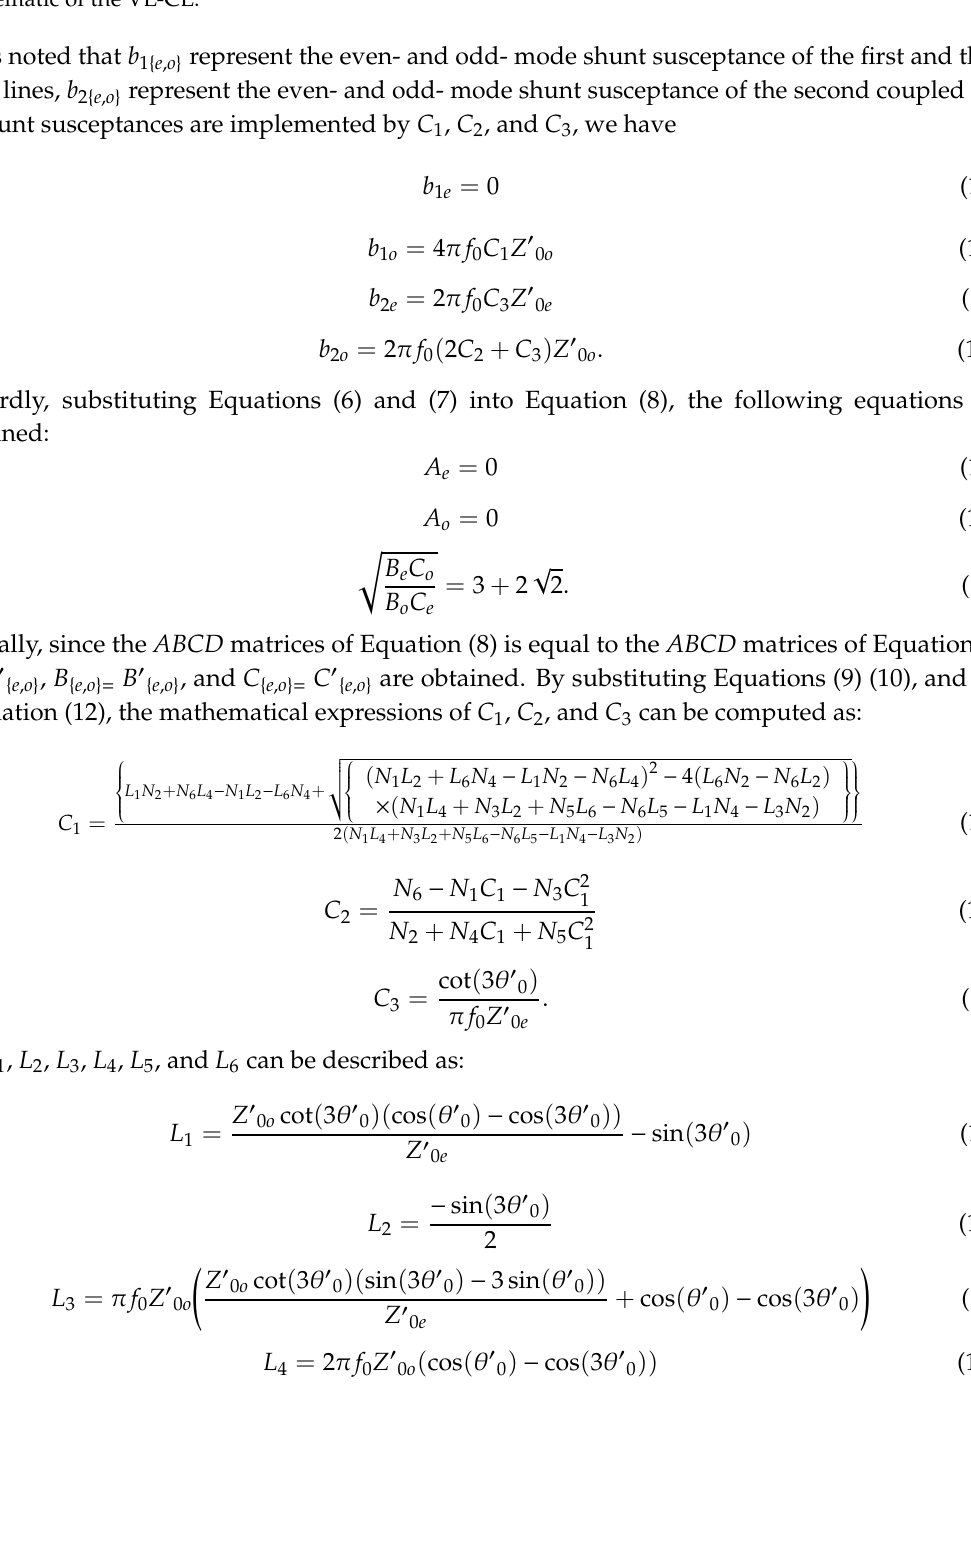
Figure 4. ( a ) Even-mode schematic of the varactors loaded coupled line (VL-CL); ( b ) odd-mode schematic of the